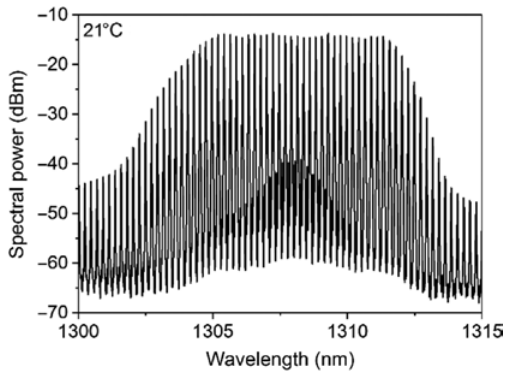
Figure 9: Hat-like distribution of longitudinal modes in a QD-lasers at ground-state saturation compared to low current.